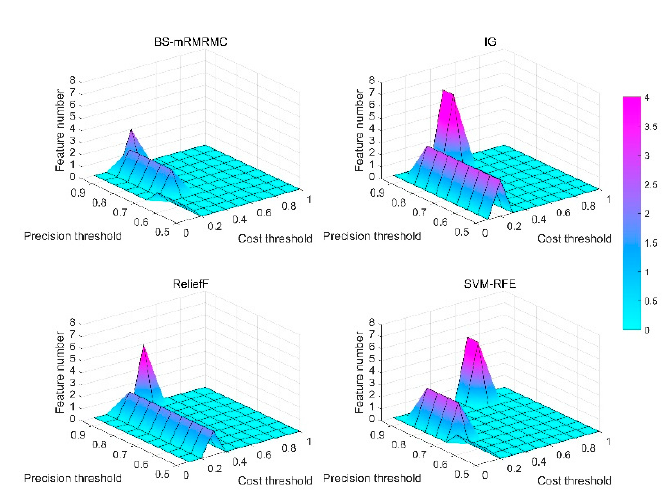
Figure 11. Surface graphs of the number of feature of best feature subset for the four methods under di ff erent computational cost constraints η c and maximum evaluation index constraints η j